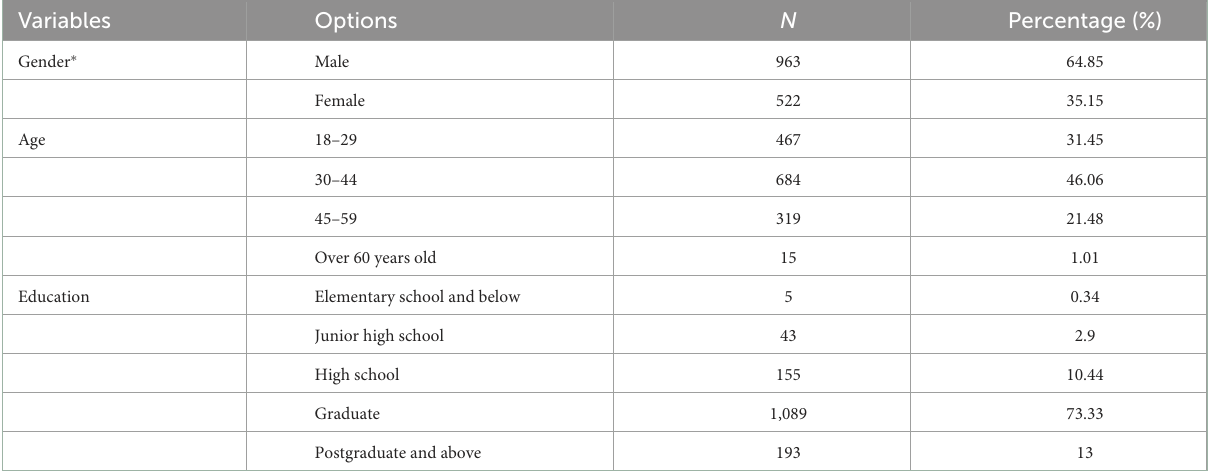
TABLE 1 Basic information of respondents.